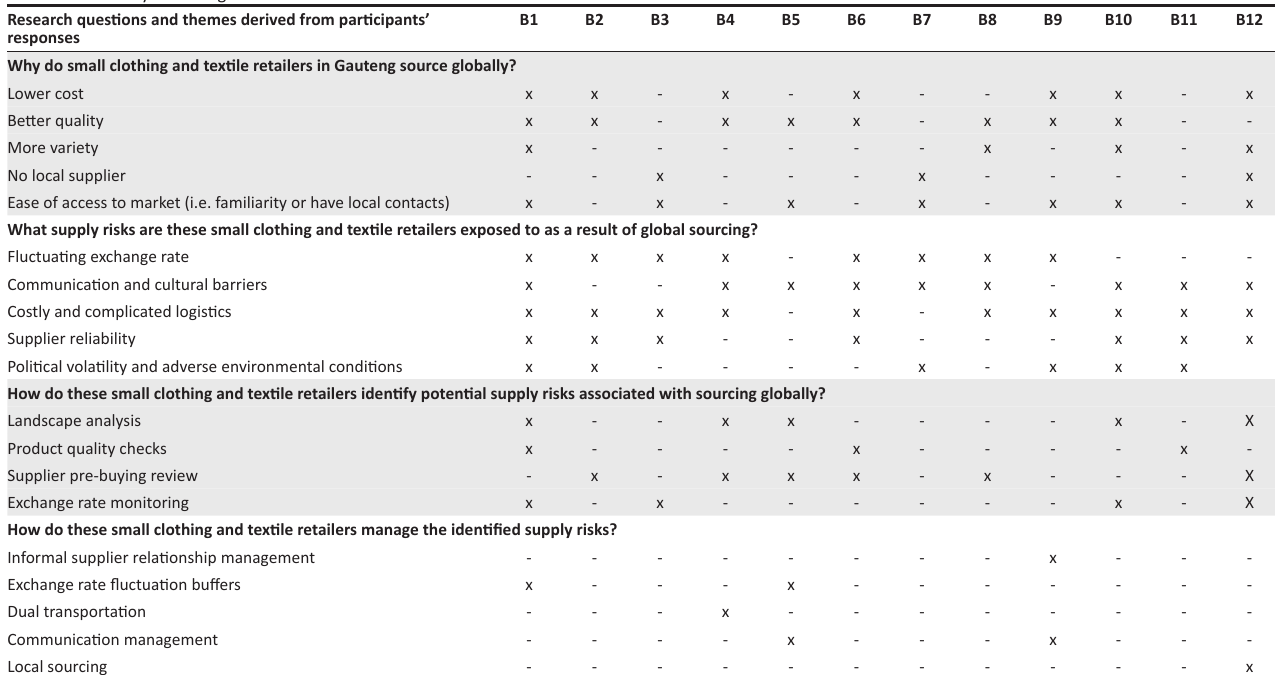
TABLE 4: Summary of